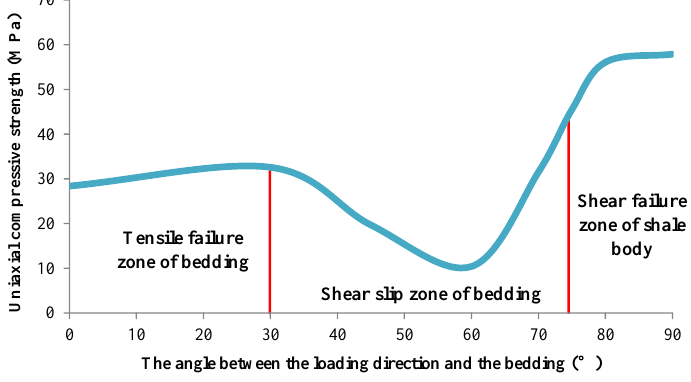
Figure 4. Core anisotropic failure law.